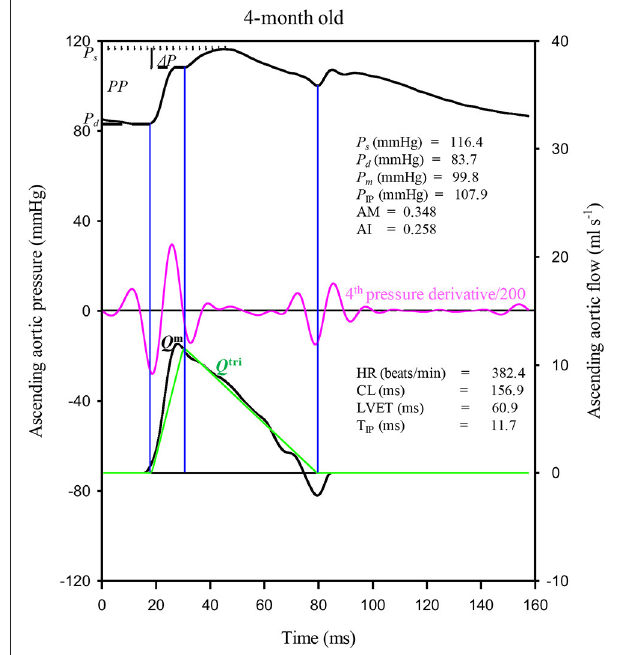
FIGURE 1 | Construction of an uncalibrated triangular flow ( Q tri ) from the measured aortic pressure waveform in one rat aged 4 months as an example. The pressure and flow ( Q m ) signals were simultaneously recorded in the ascending aorta under the anesthetized, open-chest condition. AM, augmentation magnitude, given by 1 P /( PP − 1 P ); AI, augmentation index, given by 1 P / PP ; CL, cardiac cycle length; HR, basal heart rate; LVET, left ventricular ejection time; P s , systolic pressure; P d , diastolic pressure; P m , mean pressure; PP , pulse pressure; P IP , pressure at inflection point; 1 P , given by P s − P IP ; T IP , time to inflection